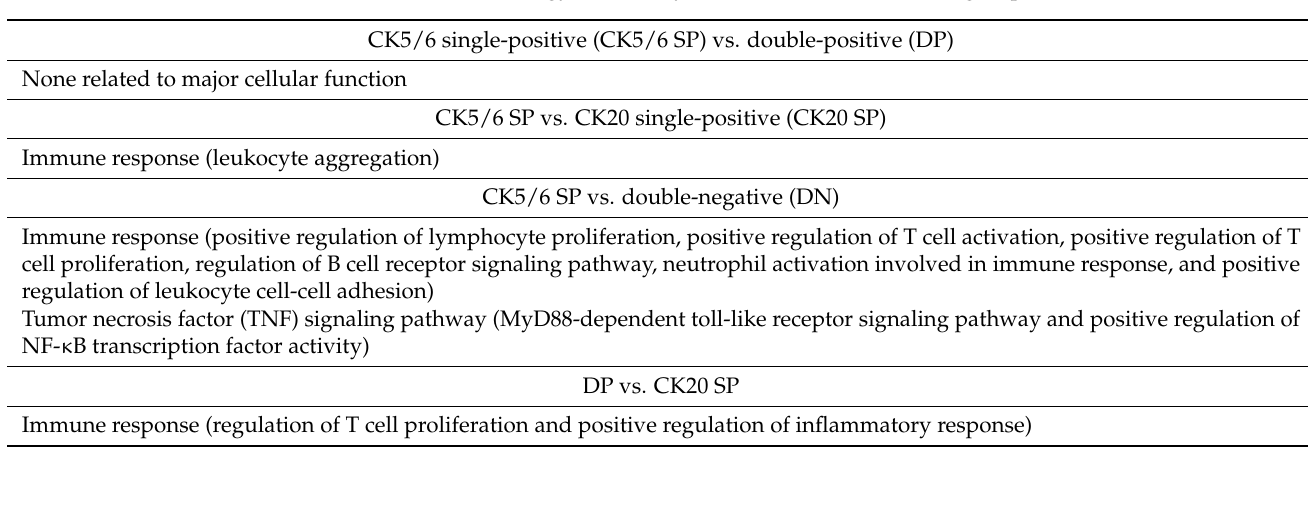
Table 1. The Gene Ontology (GO) analysis results between each subgroup.